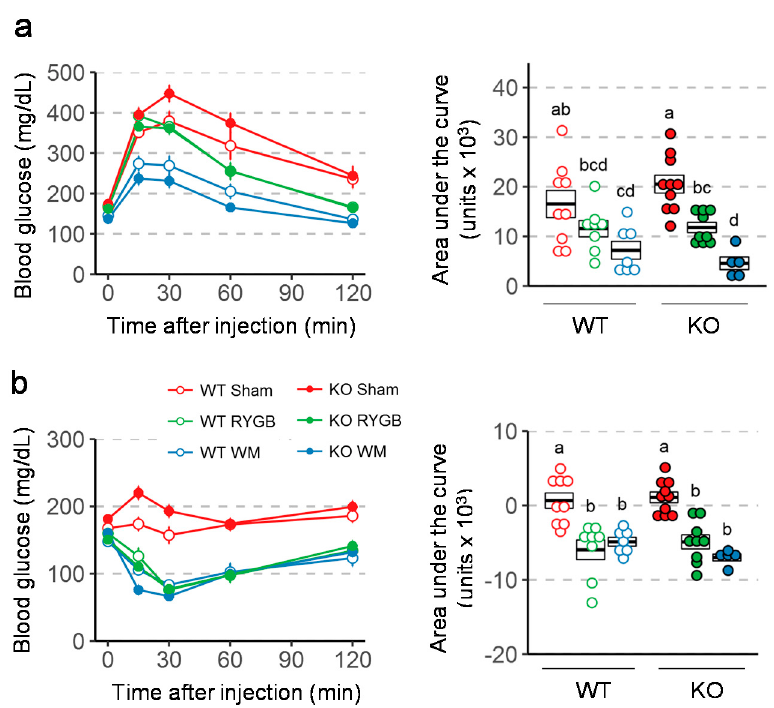
Figure 5. Effect of RYGB, sham surgery, or weight matching to RYGB by caloric restriction (WM) on glucose tolerance ( a ) and Insulin tolerance ( b ) in Y2RKO and WT mice. Data are presented as means ± SEM, or as individual data points over a box showing means ± SEM. Data that do not share the same letters are significantly different from each other ( p < 0.05, pairwise t-tests with Benjamini–Hochberg correction, FDR = 0.05).